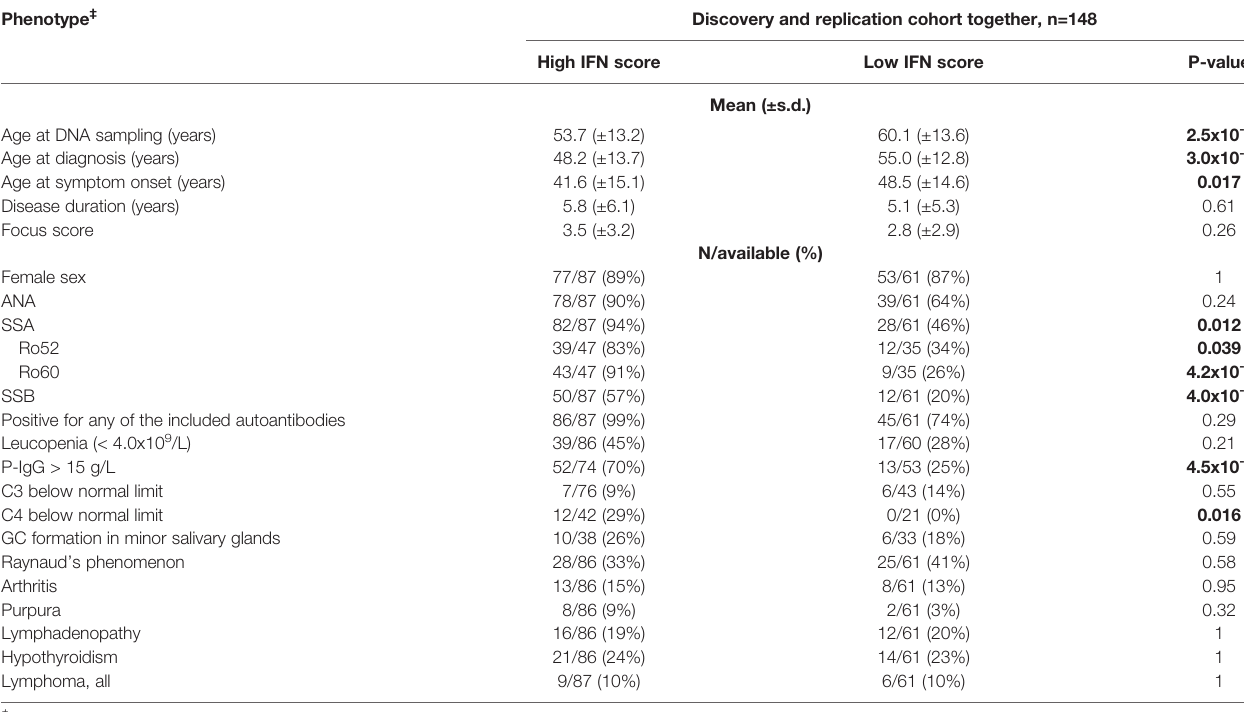
TABLE 2 | Association between DNA methylation-based IFN score status and clinical parameters and disease manifestations in patients with primary Sjögren ’ s syndrome (pSS) summarized for discovery and replication cohorts